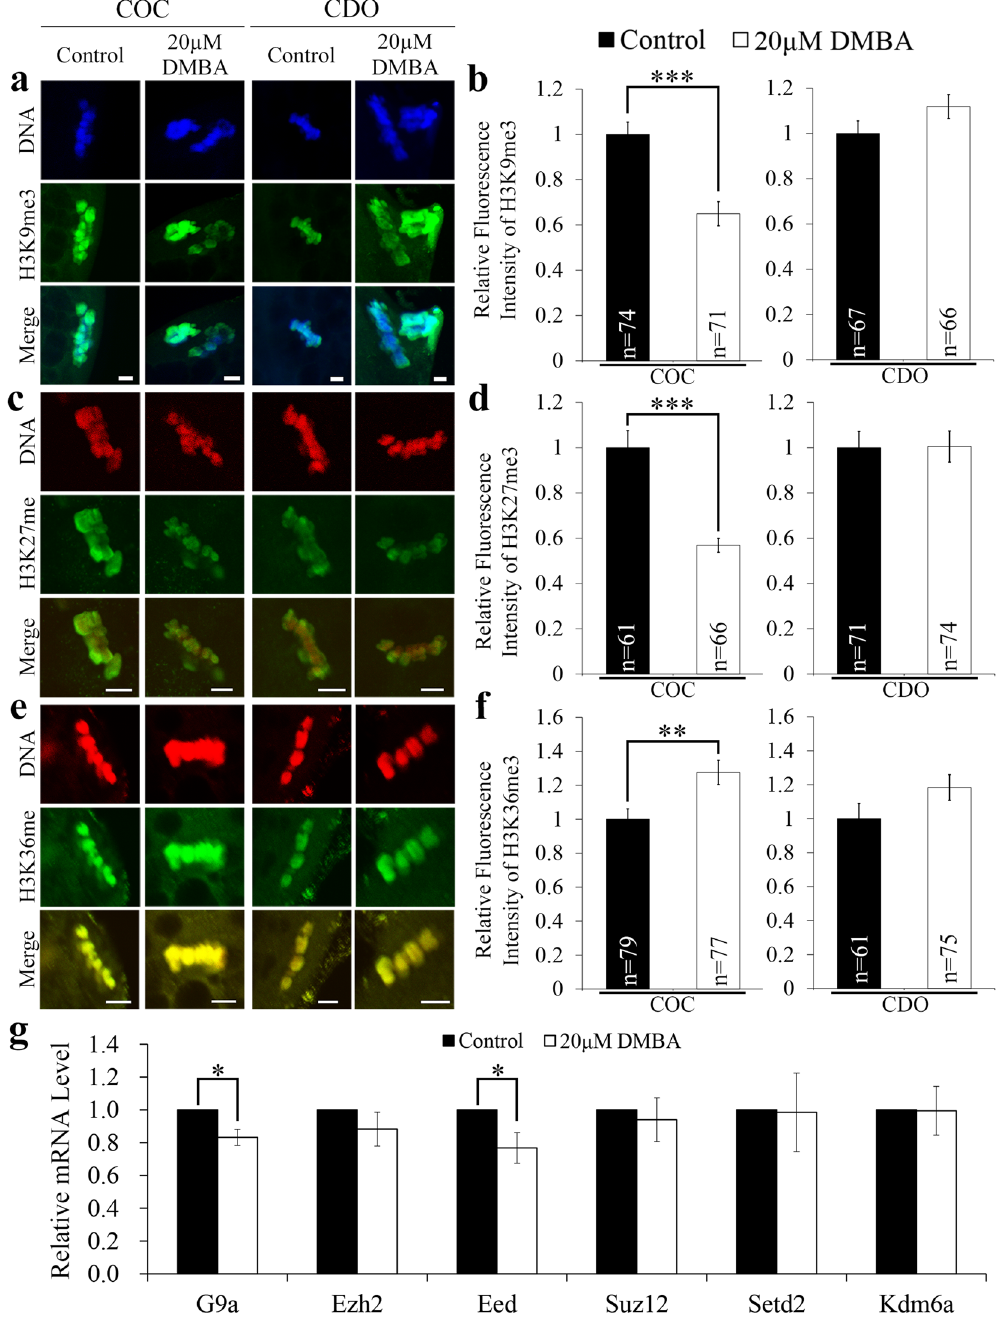
Figure 4. DMBA modified histone methylation markers of mature oocytes from COCs. Representative fluorescence images of mature oocytes were presented for H3K9me3 ( a ), H3K27me3 ( c ) and H3K36me3 ( e ). Scale bar, 5 μ m. The relative fluorescence intensity of H3K9me3 ( b ), H3K27me3 ( d ) and H3K36me3 ( f ) were presented as mean ± SEM. ( g ) The relative mRNA level of G9a, Ezh2, Eed, Suz12, Setd2 and Kdm6a in mature oocytes. * P < 0.05; ** P < 0.01 and *** P <